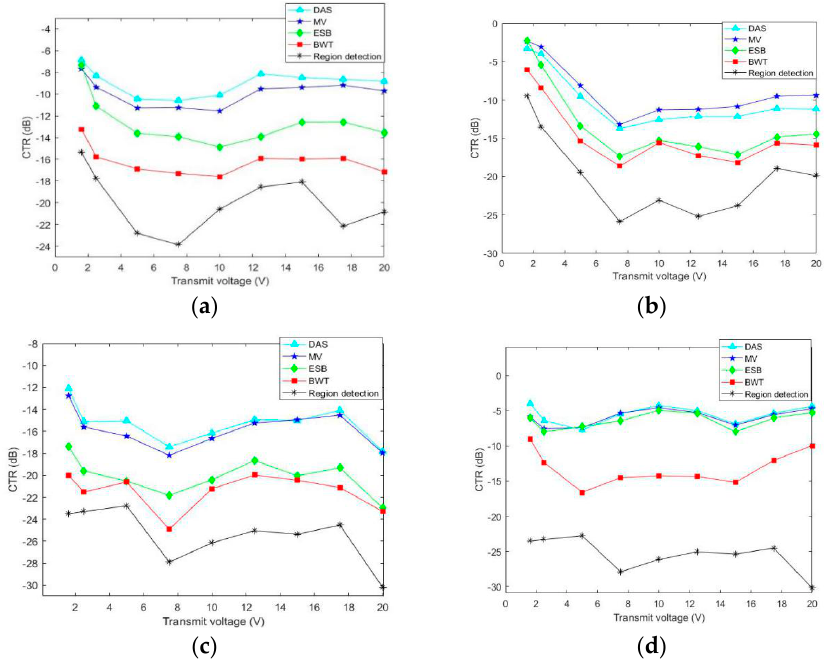
Figure 9. The image contrast-to-tissue ratio (CTR) curve between different beamformers: ( a ) 3 MHz; ( b ) 4 MHz; ( c ) 5 MHz; and ( d ) 6.25 MHz.